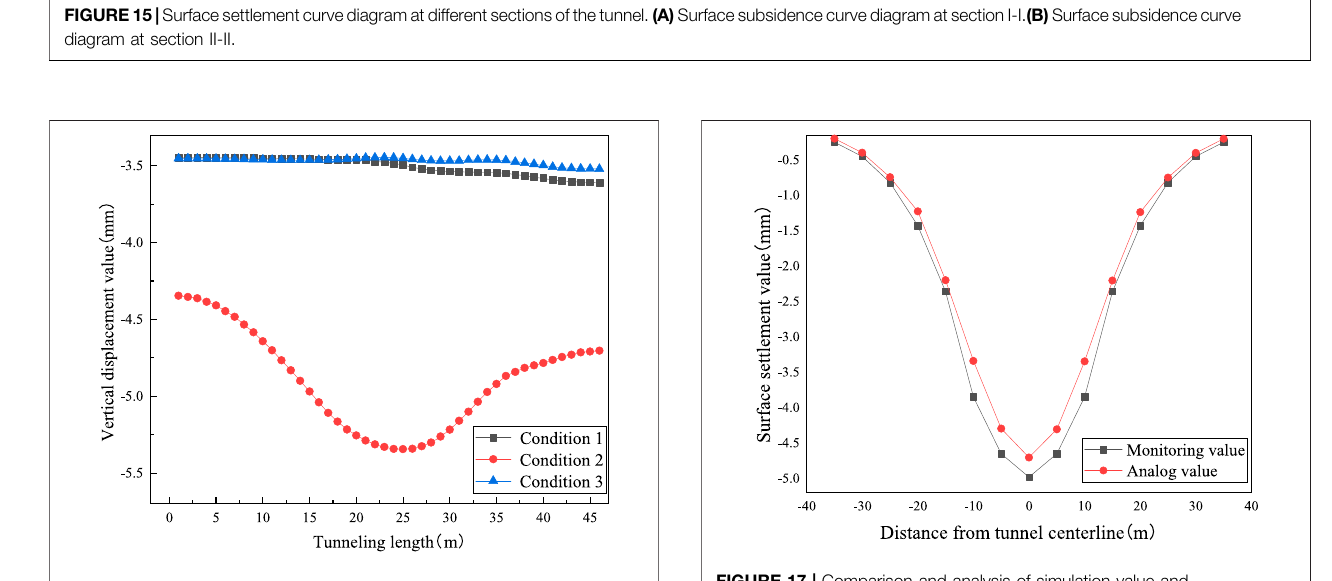
FIGURE 16 | Longitudinal surface settlement curve under different conditions.